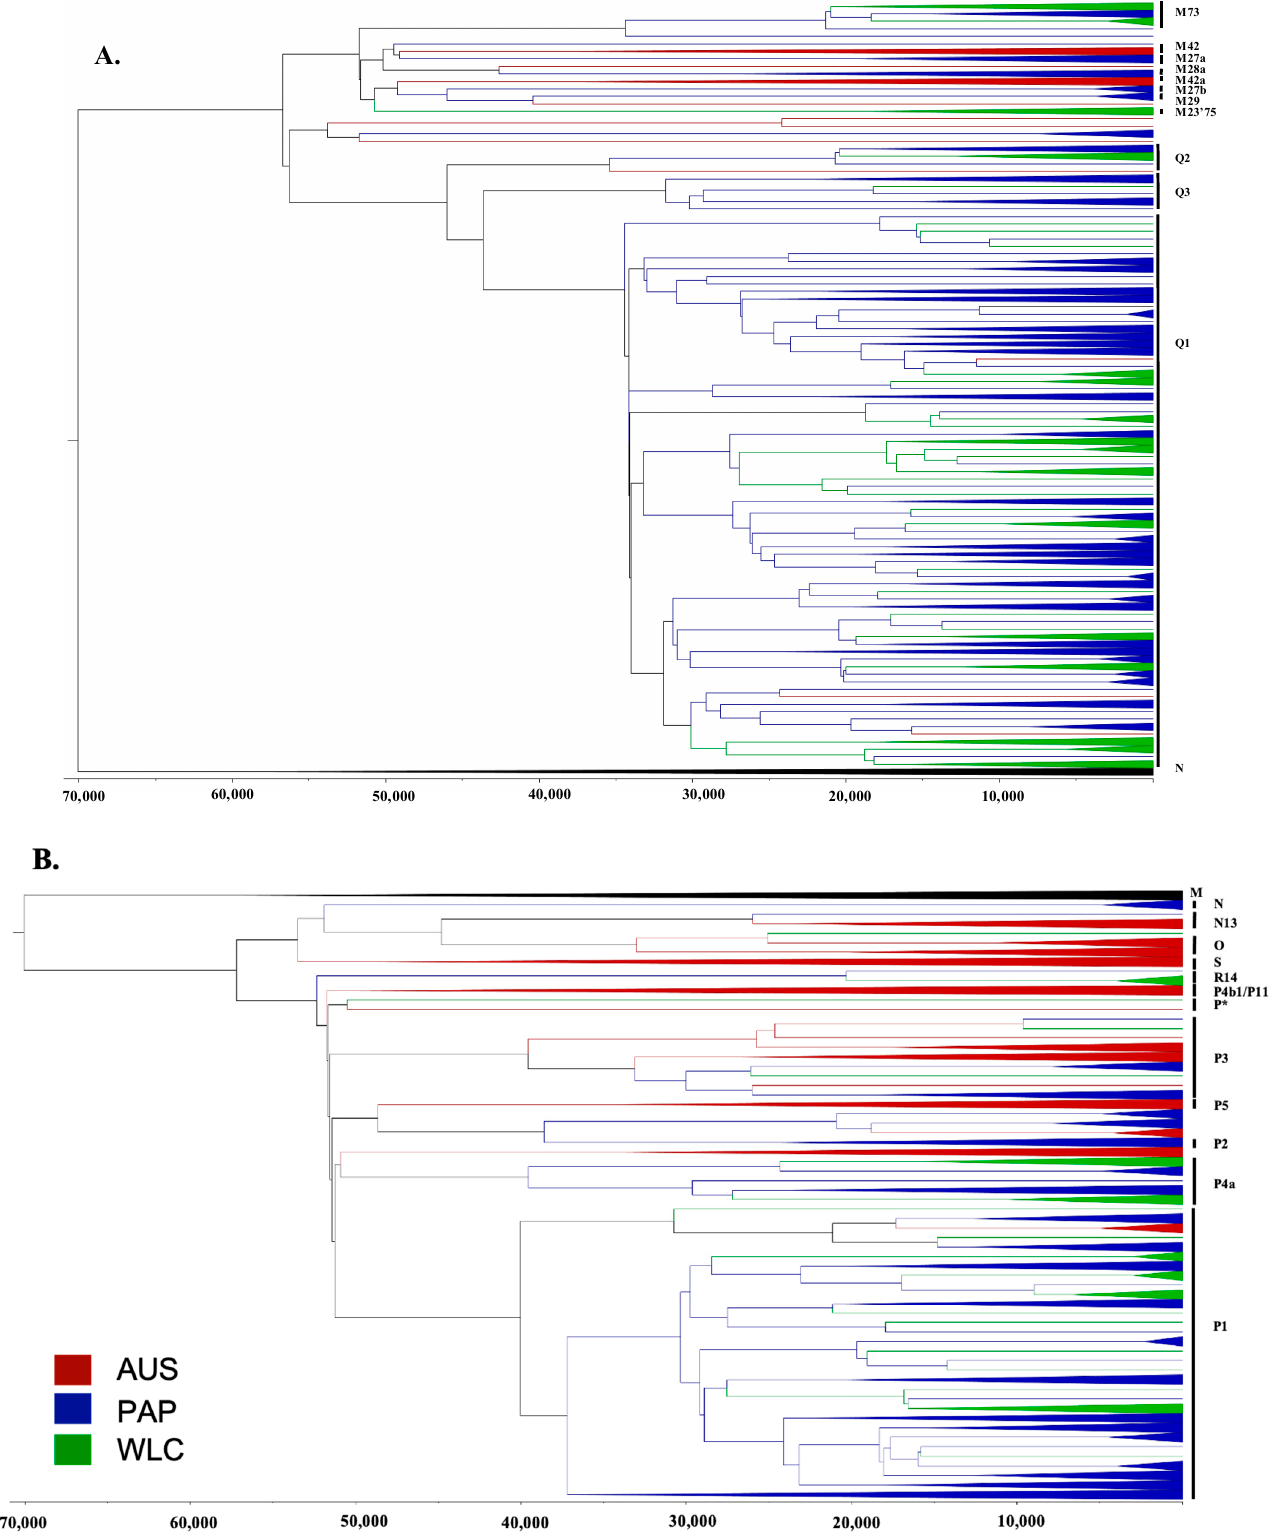
Figure 2. BEAST consensus tree for 656 mitogenomes from Wallacea, New Guinea, and Australia. The tree is based on putative Australo-Papuan-affiliated haplogroups, split into the two main non-African macrohaplogroups M ( A ) and N ( B ). Samples from Wallacea (WLC) are coloured green, with those from Papua (PAP; i.e., New Guinea and Island Melanesia) and Australia (AUS) being coloured blue and red, respectively. All monophyletic clades are collapsed.